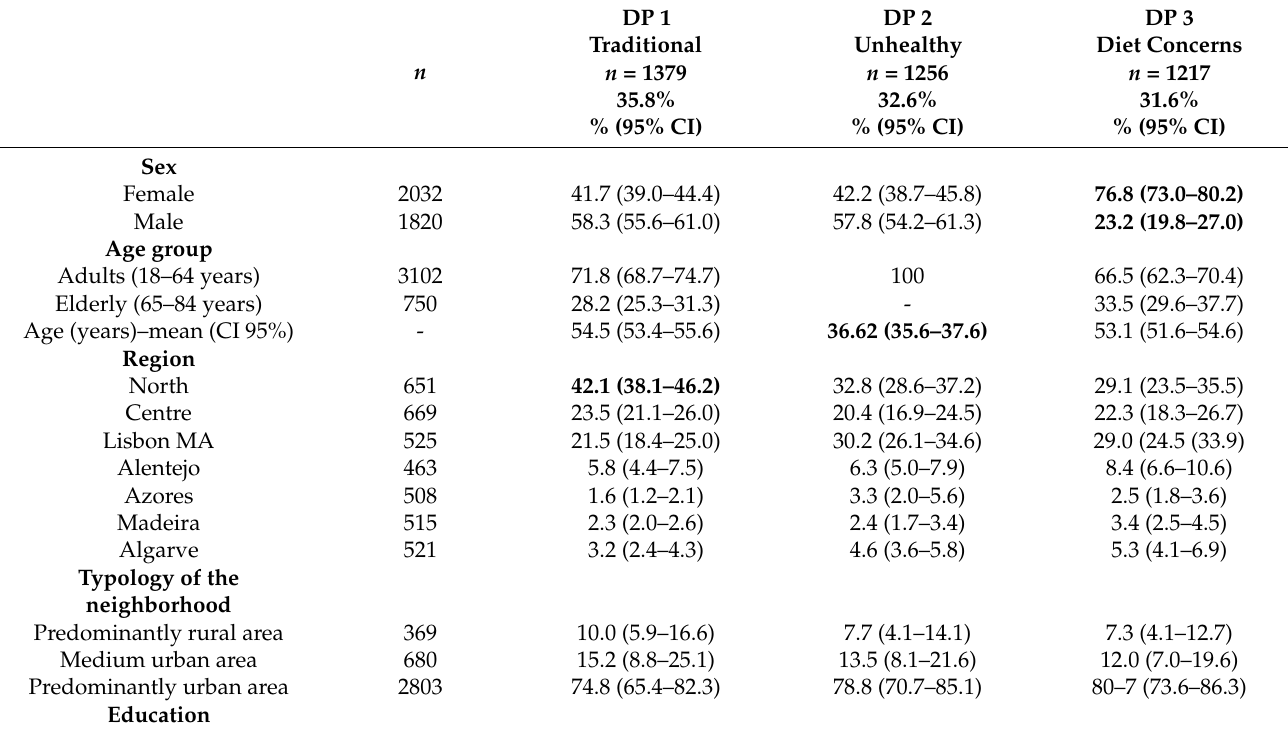
Table 2. Sociodemographic characteristics, physical activity and BMI according to dietary patterns among Portuguese population aged 18–84: The UPPER